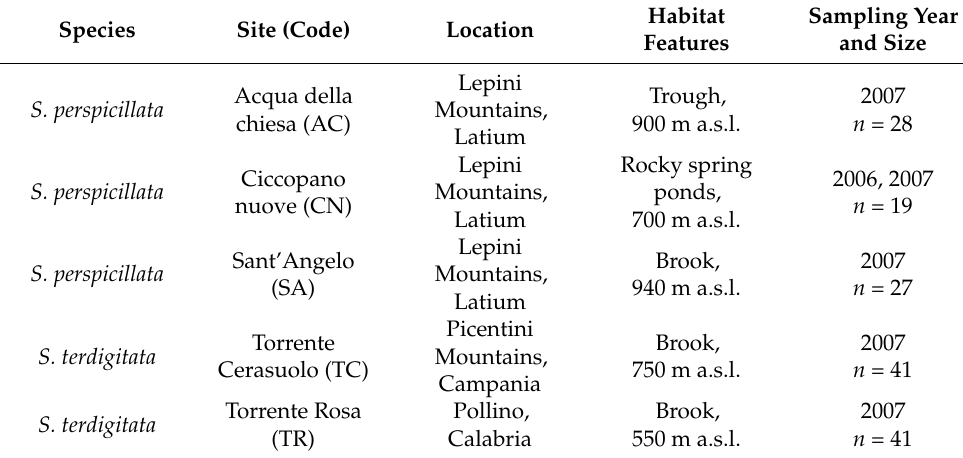
Table 1. Summary information about the sites of Salamandrina perspicillata and S. terdigitata used in this study; site codes are the same as in supplementary Table S1.